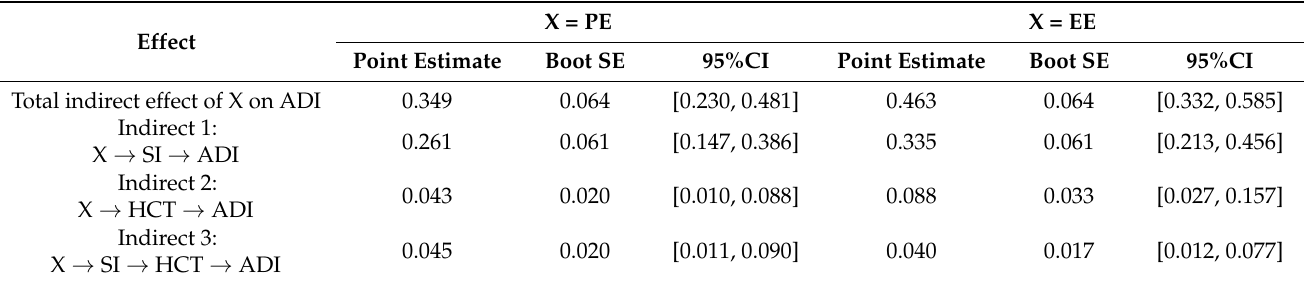
Table 5. Direct and indirect effects.